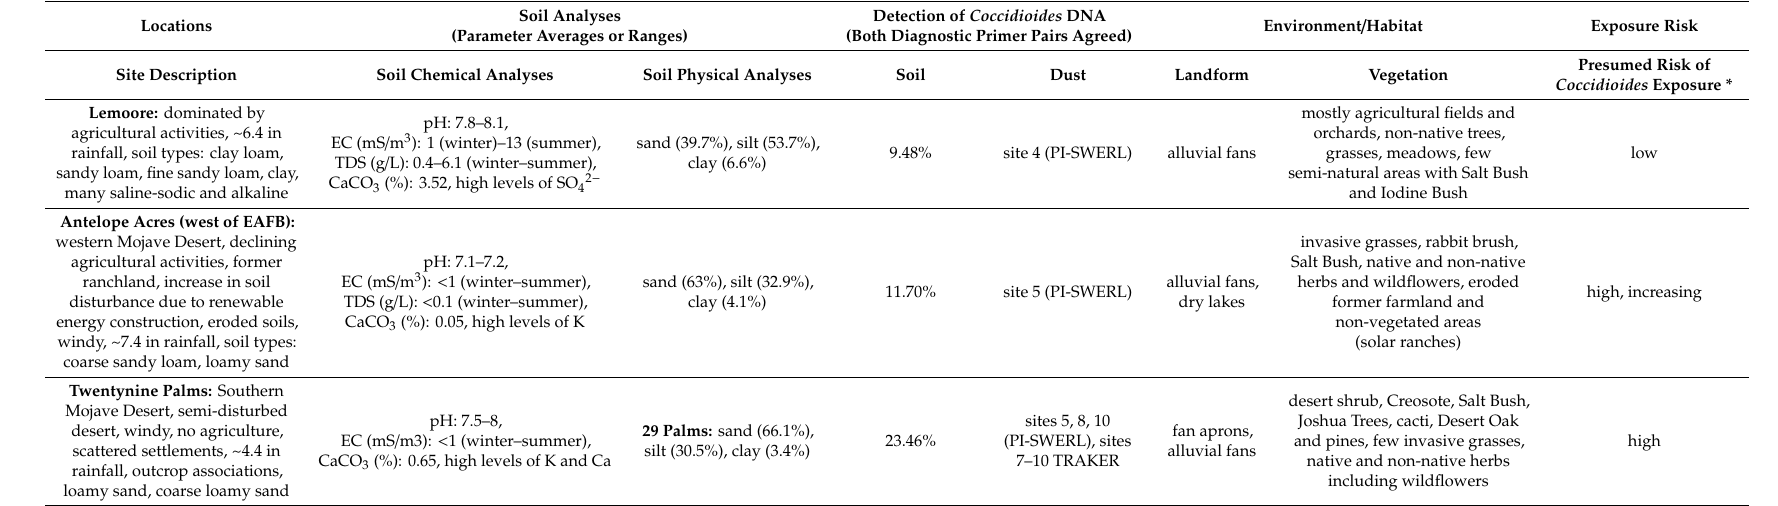
Table 8. Summary of soil analyses for soil chemical and physical parameters and detection of Coccidioides DNA in soil and dust samples. A brief site description with indication of dominant vegetation and risk of exposure to the pathogen is indicated, as